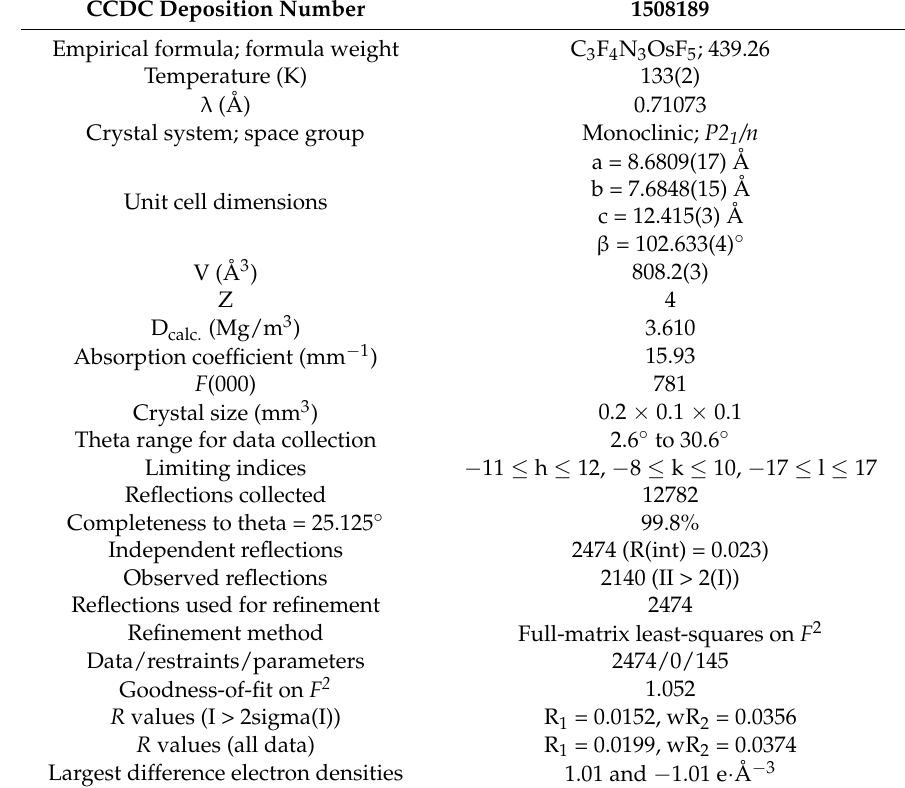
Table 1. X-ray structure experimental details.